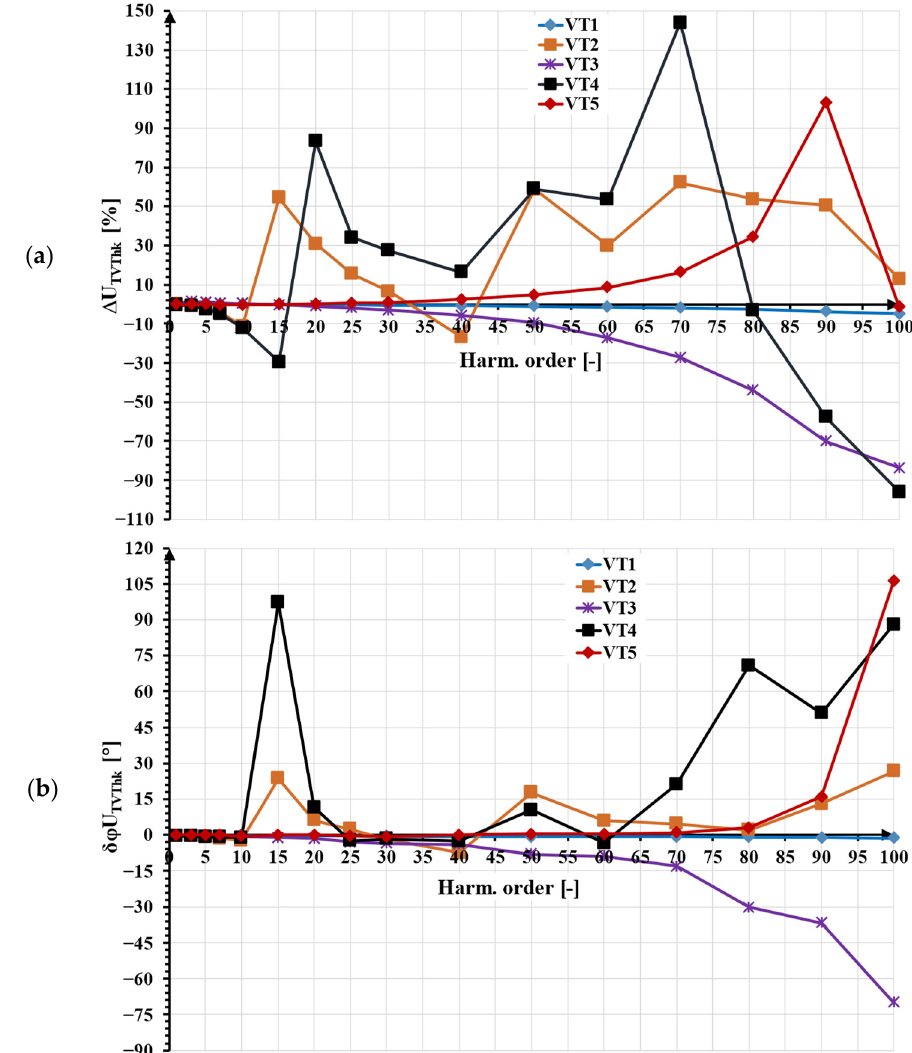
Figure 10. Comparison of the highest absolute values of the ( a ) voltage error and ( b ) phase ment determined for inductive VTs displacement determined for inductive VTs [3].